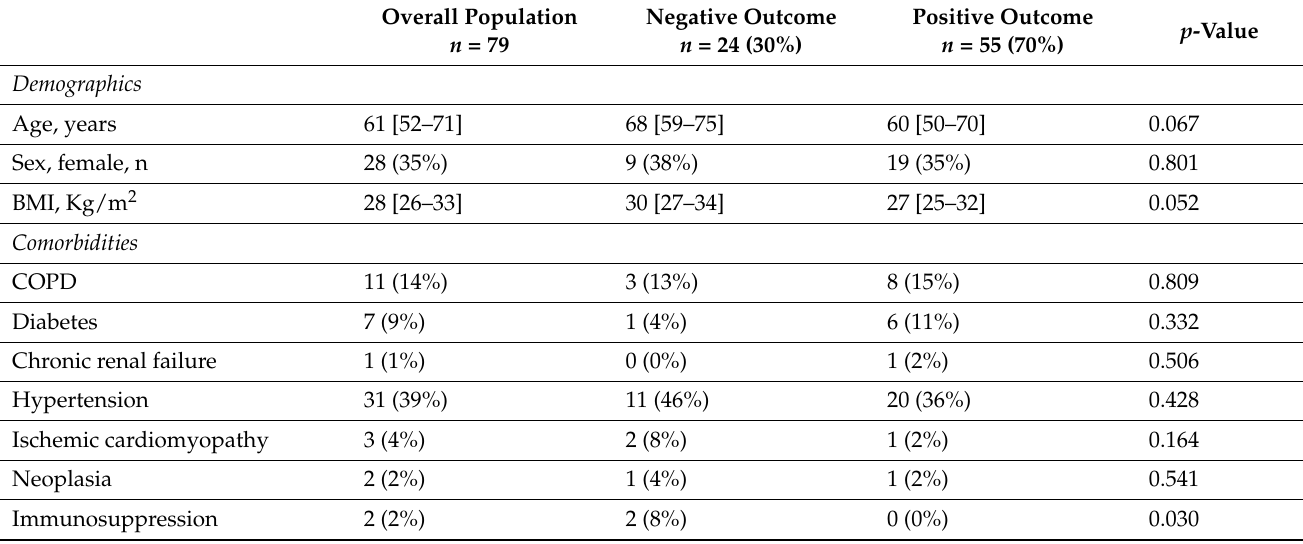
Table 1. Main demographic variables, comorbidities and respiratory parameters of enrolled